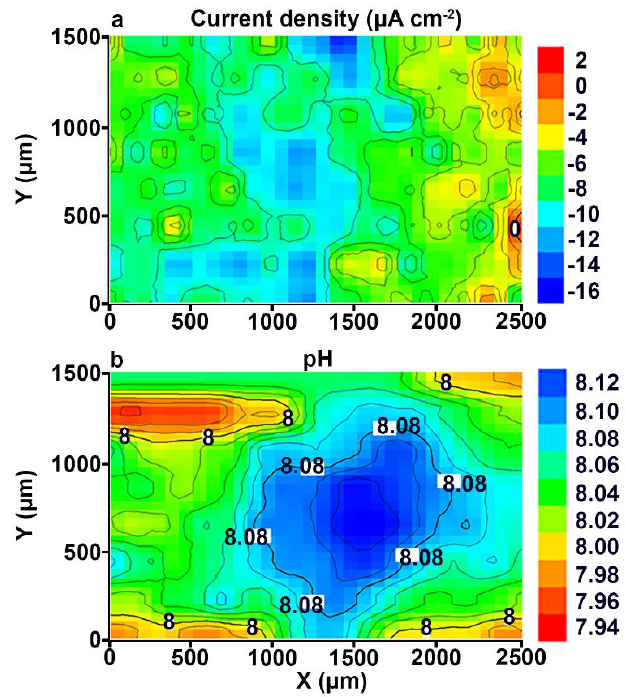
Figure 4. The ( a ) SVET and ( b ) SIET diagrams of the current density and pH distribution on the surface of the welded joint of the 1579 aluminium alloy sample with PEO-coating after 87 h of the exposure to 0.5 M NaCl. The welded joint area is a cathodic zone.